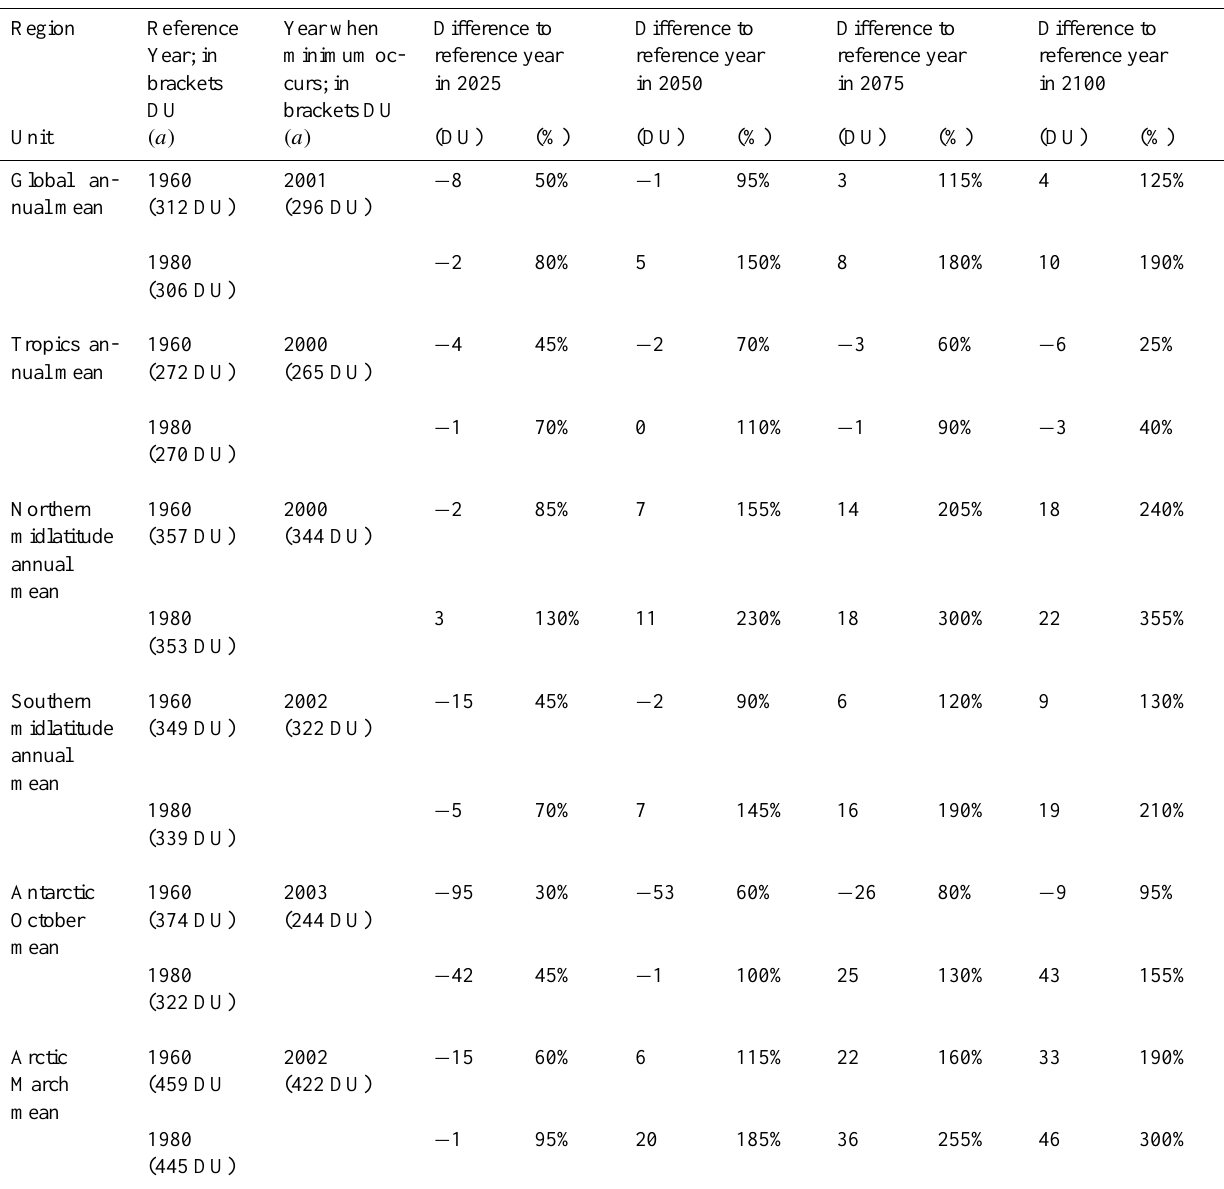
Table 4. Summary of the extent to which ozone has returned to 1960 and 1980 levels from its absolute minimum, expressed as percentages calculated from the 1980 baseline-adjusted timeseries of all 17 CCMs’ reference simulations. 0% denotes that ozone has not increased above the minimum, 50% denotes that ozone at this date is halfway between the minimum observed and the 1960 or 1980 level, 100% denotes that ozone has returned to the 1960 or 1980 level, and > 100% denotes that ozone exceeds the 1960 or 1980 level at this